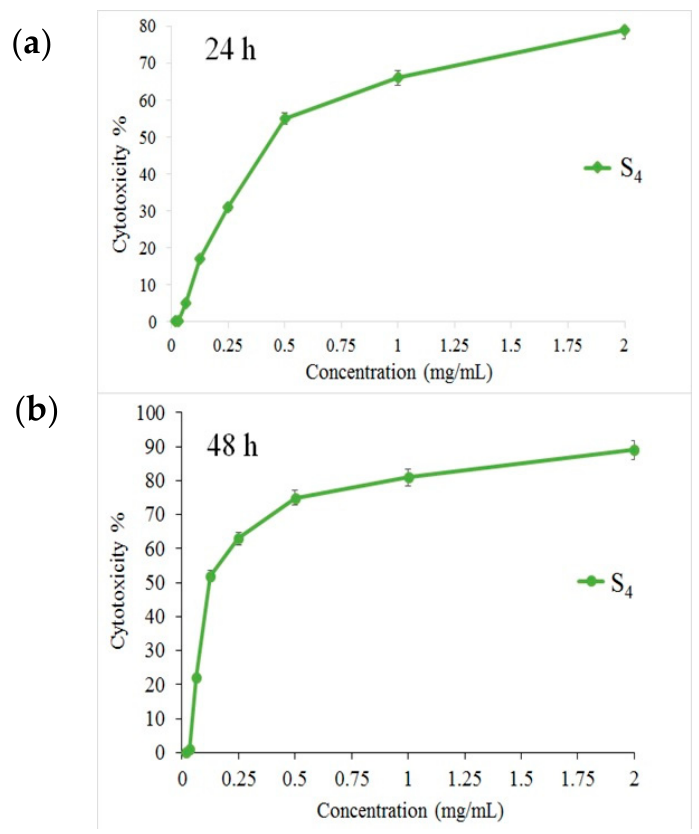
Figure 9. The relative in vitro cell viability of optimized Fe 3 O 4 /CdWO 4 /PrVO 4 (MTT assay). PANC1 cells incubated with Fe 3 O 4 /CdWO 4 /PrVO 4 for ( a ) 24 h and ( b ) 48 h.